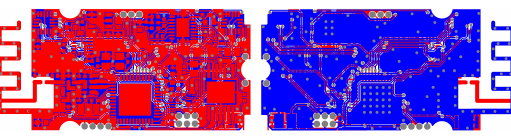
Figure 5. SPW-2: Top copper layer (left) and bottom copper layer (right) of the circuit board. SPW-2 employs a meandered inverted-F antenna.